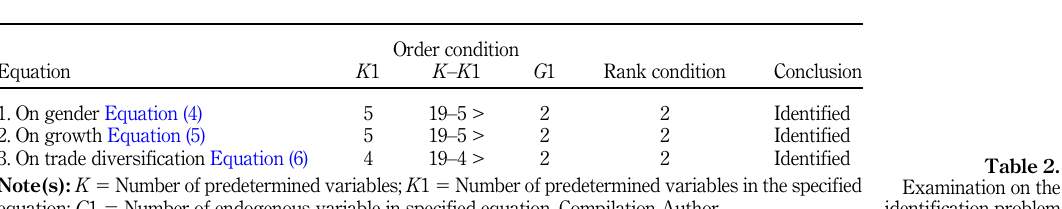
Table 1. Descriptive statistics: summary